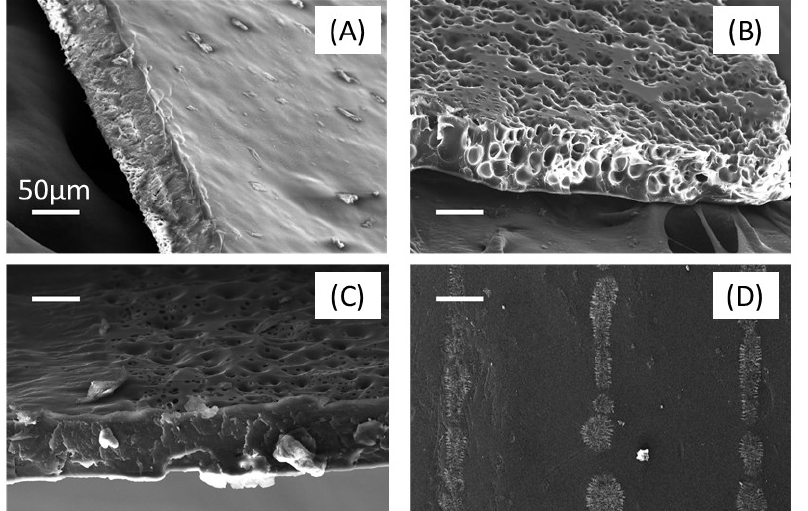
Figure 5. SEM images of morphologies (bars are 50 µ m) of PLA films obtained after a gas-foaming process. ( A ) A PLA film that was not covered with the barrier layer; ( B ) a PLA film that was preliminarily covered on the whole surface with the barrier layer; ( C ) a PLA film that were partially covered by the barrier layer (on the right side) and shows the presence of surface pores, only where the barrier layer was present; ( D ) a PLA film with aligned porosity.